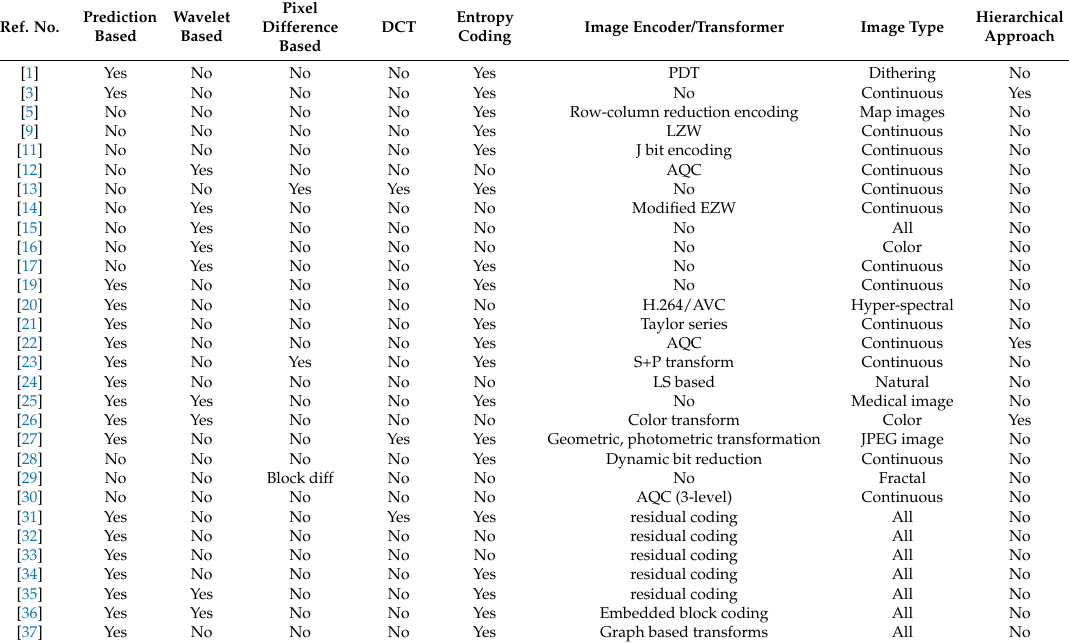
Table 1. Technical scenarios of few existing lossless and near lossless image compression algorithms. Ref. No. Prediction